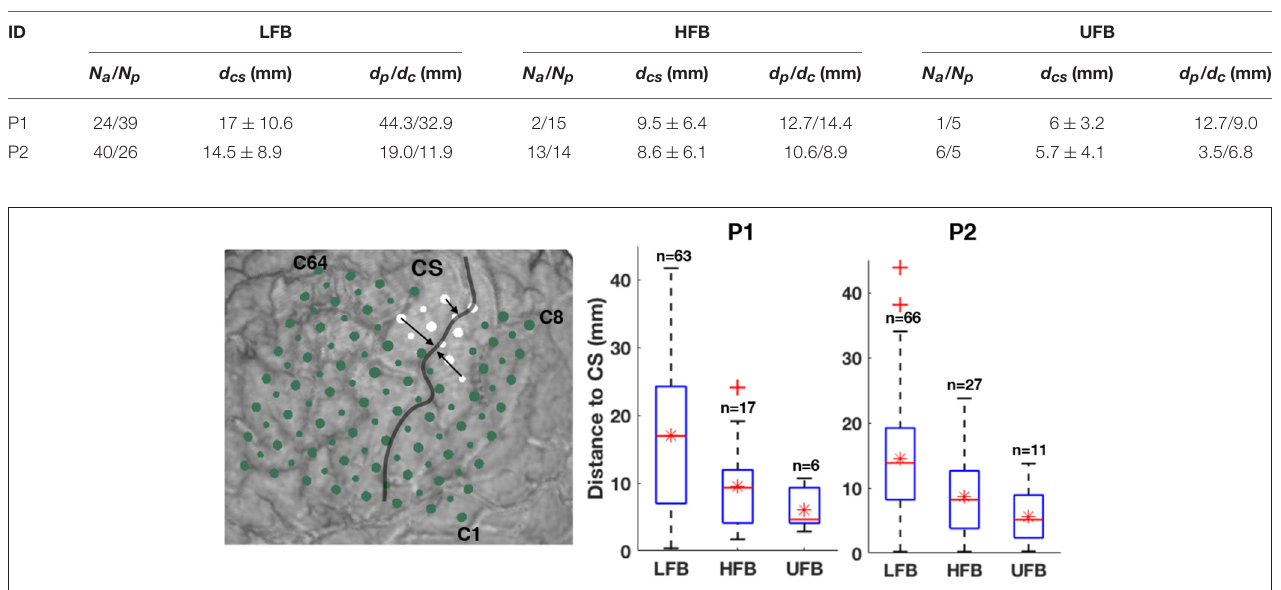
TABLE 2 | Distributions of spatial patterns relative to CS and DCS( + ).